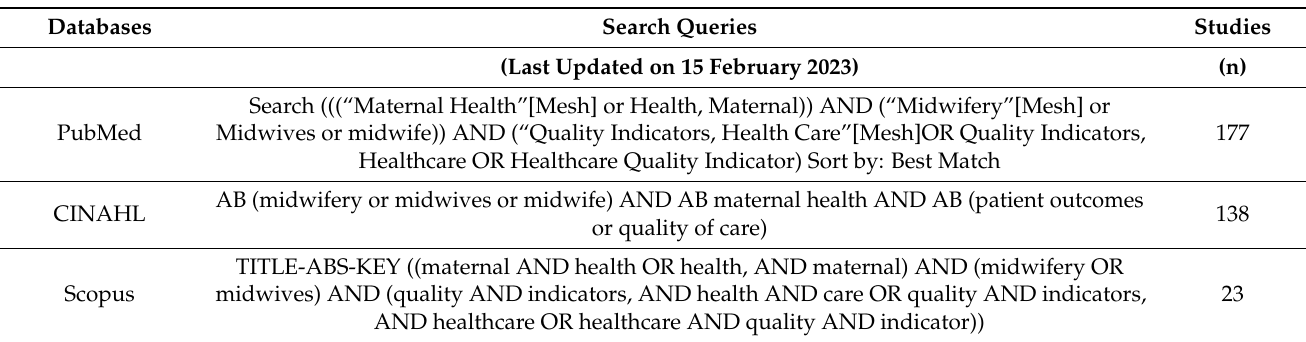
Table 1. Literature search